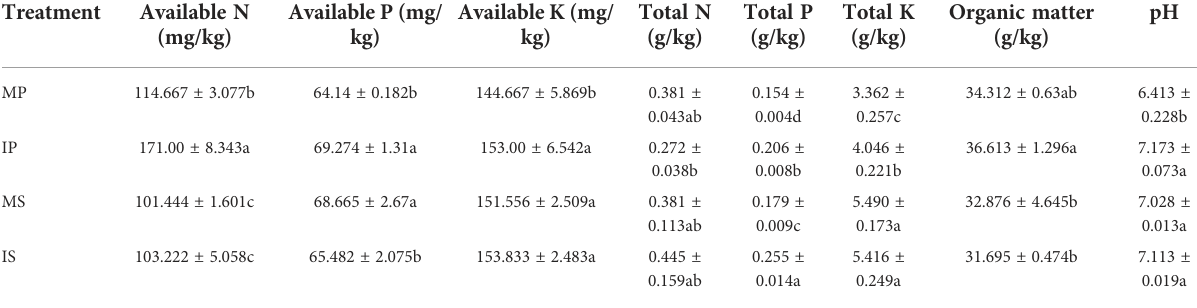
TABLE 1 Soil physicochemical properties of the tested rhizosphere soils.